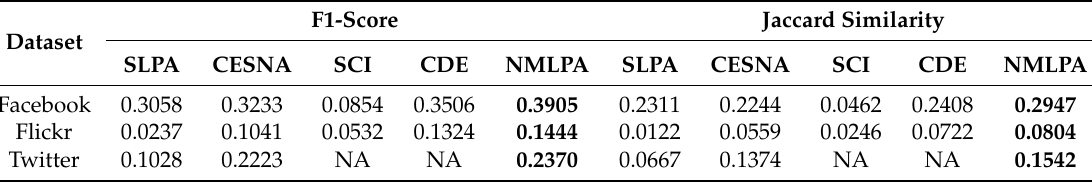
Table 2. Performance comparison (in terms of F1-score and Jaccard Similarity) on attributed networks with overlapping ground-truth communities (bold numbers represent the best results). NA means that the task is not completed in limited